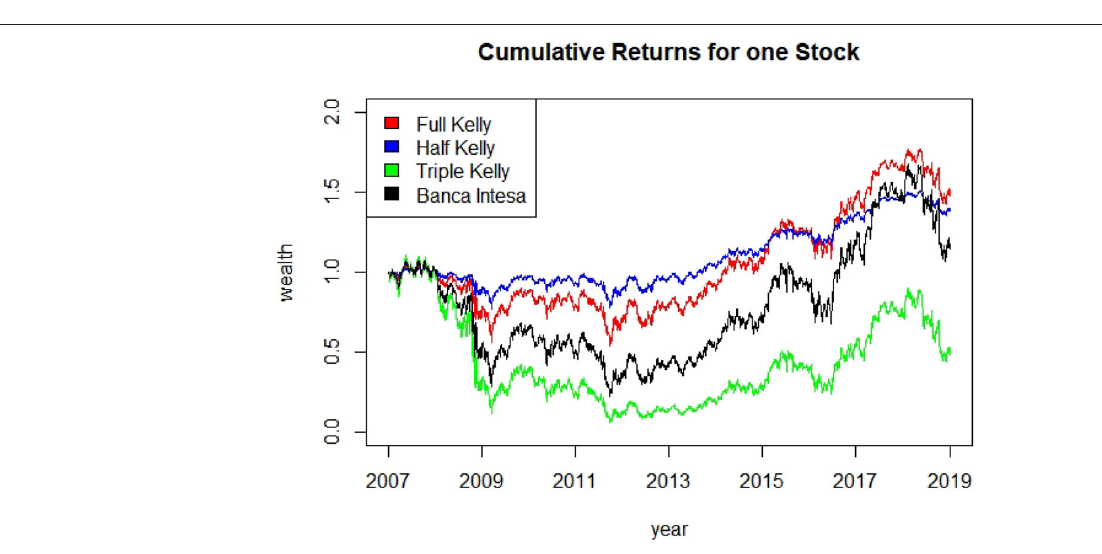
FIGURE 3 | Cumulative returns for Kelly strategies on the Banca Intesa equity (daily